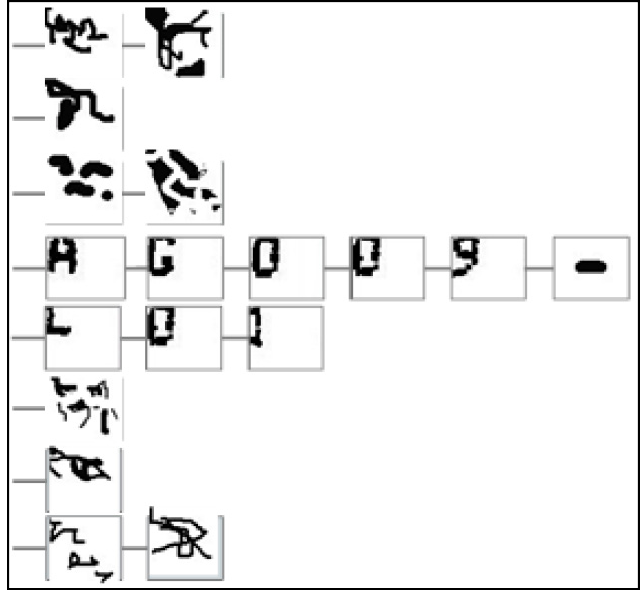
Figure 4. Information obtained in the previous